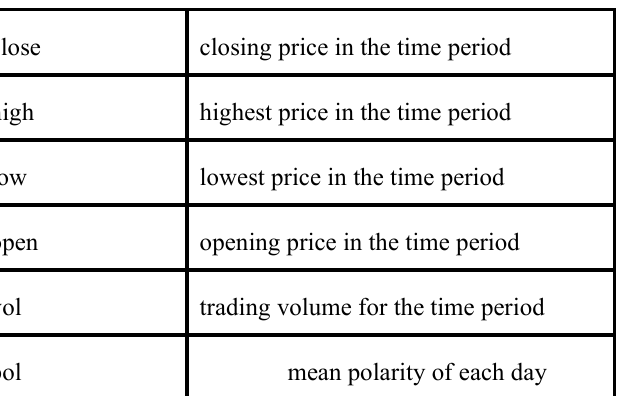
Table 2. Feature set for the deep learning